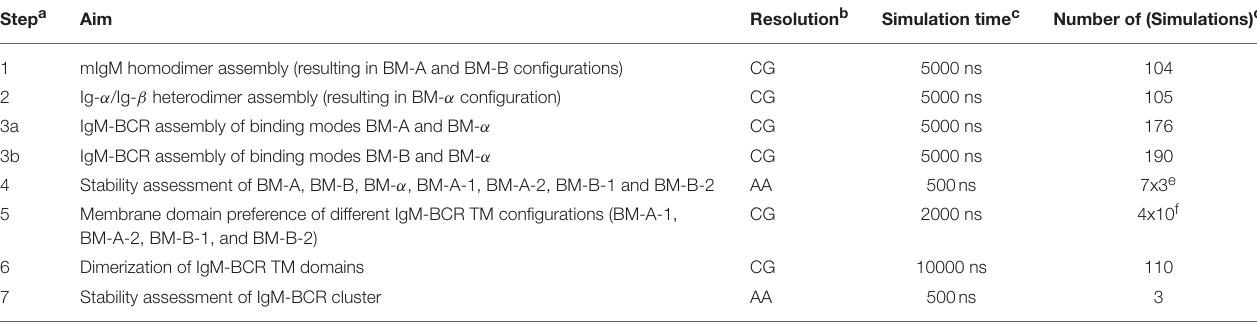
TABLE 2 | List of coarse-grained (CG) and all-atom (AA) MD simulations performed to study the conformation of the IgM-BCR transmembrane domain. Step a Aim